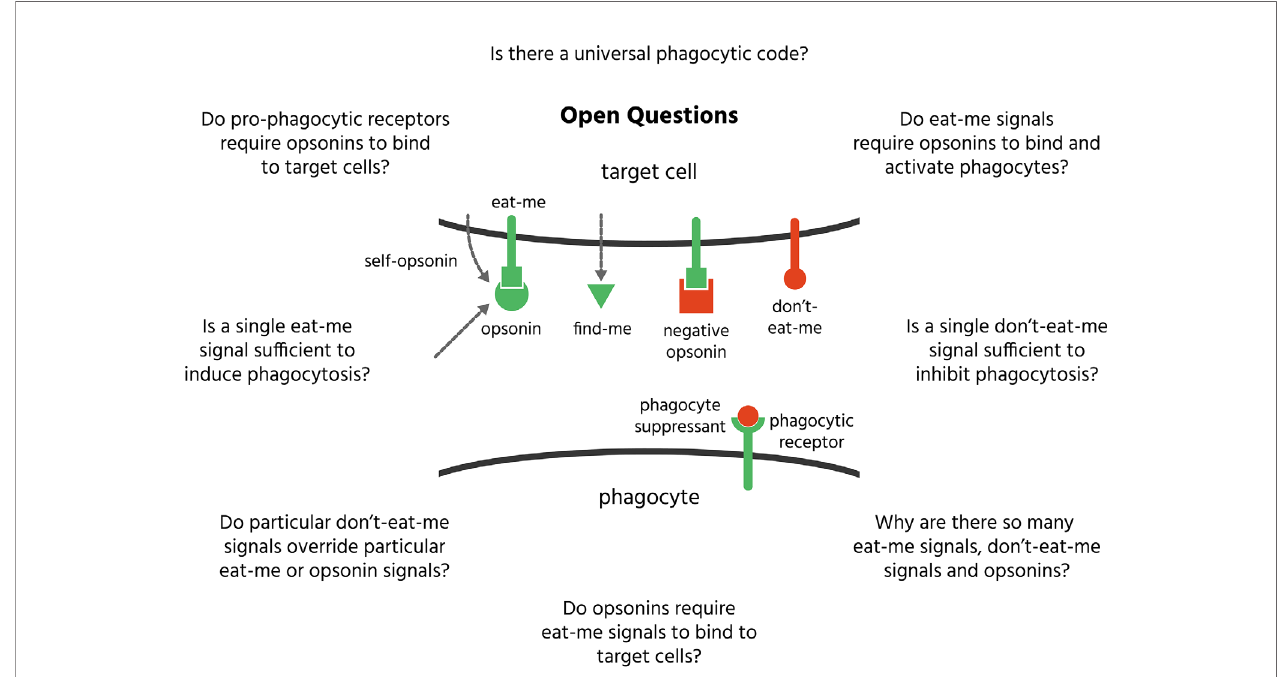
FIGURE 8 | Open questions on the phagocytic code. Multiple signals present on the target cell surface stimulate or inhibit phagocytosis of these targets by phagocytes. How these signals combine to determine whether the target is phagocytosed or not is known as the phagocytic code. However, there are multiple open questions as to how this code works, some of which are listed here and discussed in the